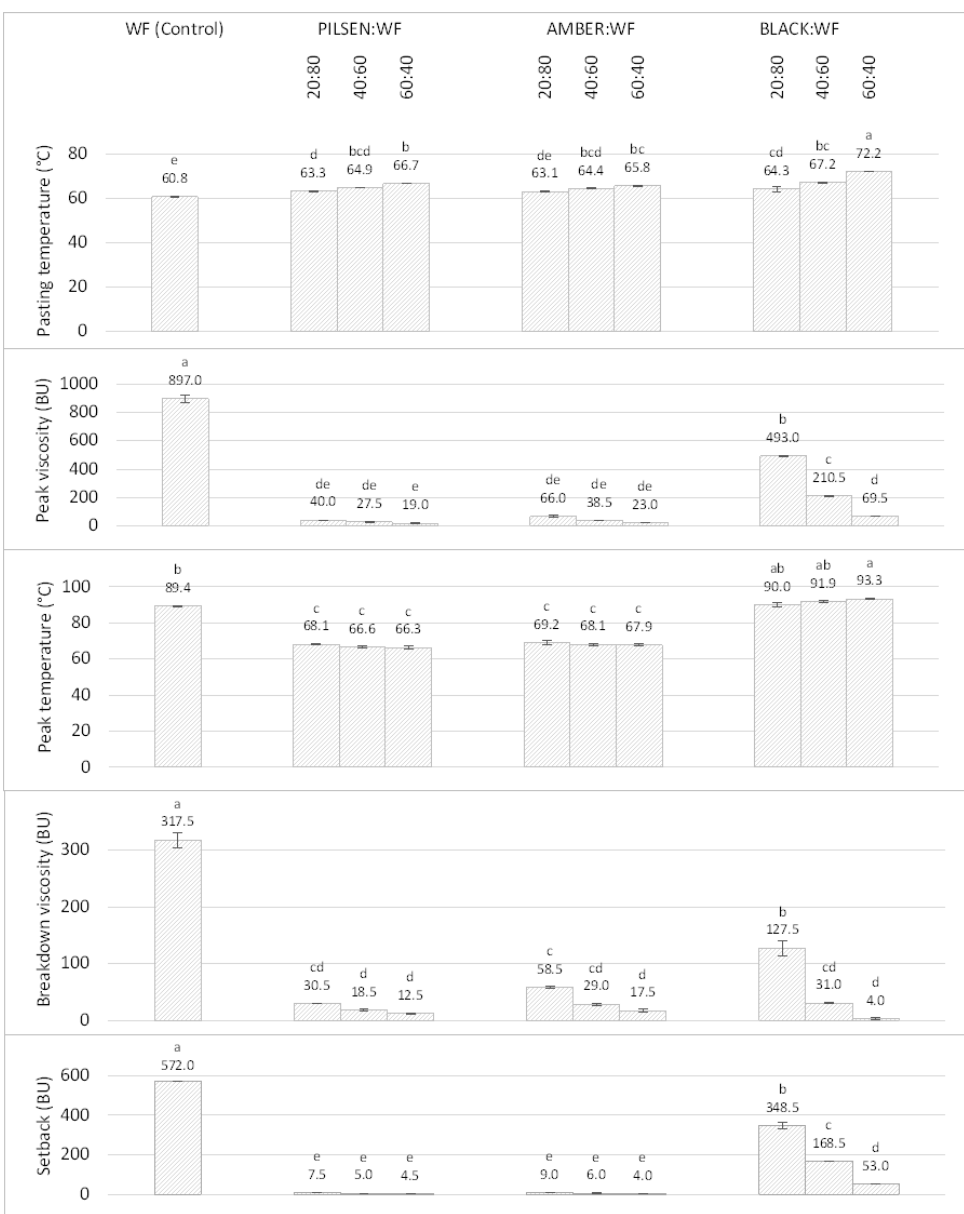
Figure 2. Pasting properties of malted barley and wheat composite flours. WF—Wheat flour. The values are Mean ± SD ( n = 2). Different letters (a–e) indicate statistically significant differences ( p < 0.05).